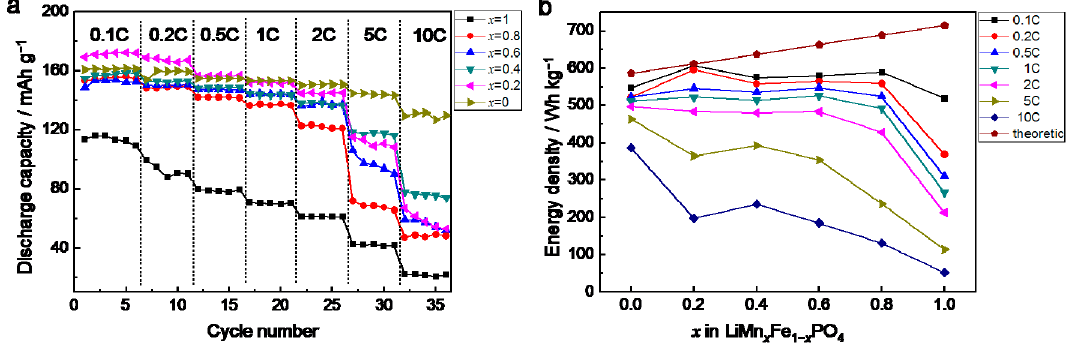
Figure 10. Rate property of LiMn x Fe 1 − x PO 4 /C: ( a ) discharge capacity at different rates; ( b ) variation of energy density at different rates.